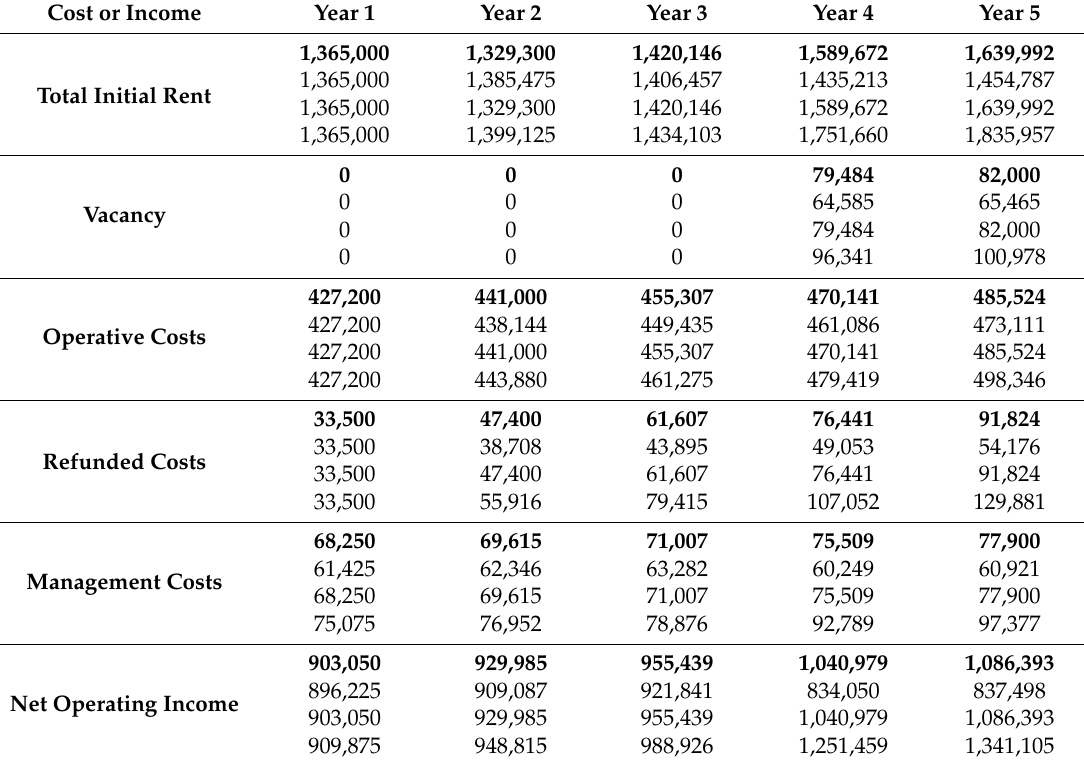
Table 7. Calculation of Net Operating Income.